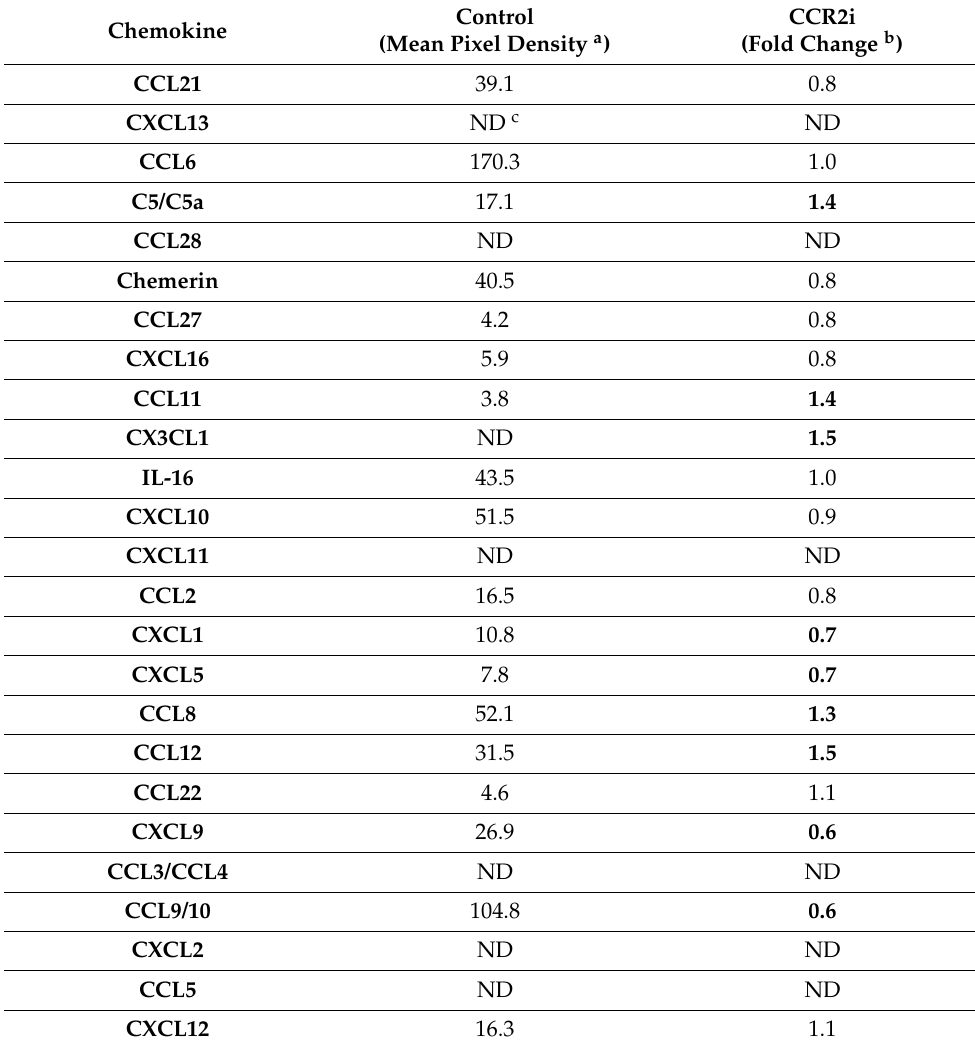
Table 2. Chemokine levels in control mice and fold–changes upon CCR2i treatment in MB49 tumor bearing mice at day